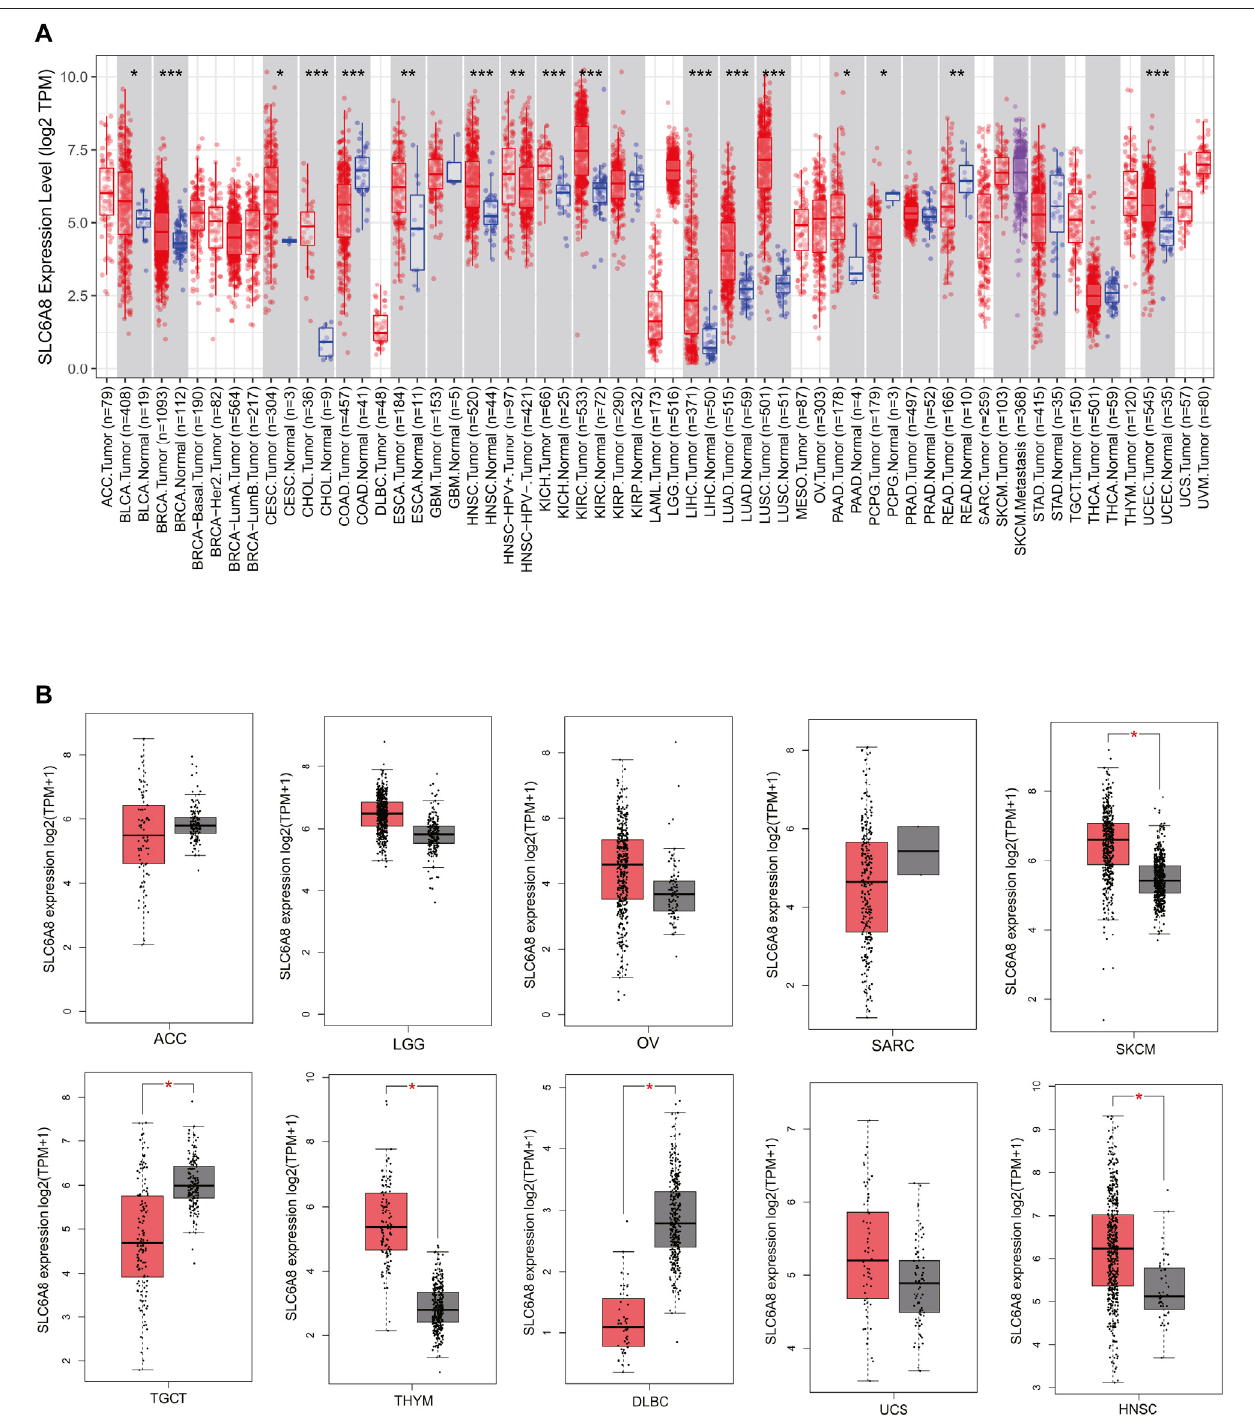
FIGURE 1 | SLC6A8 expressionpro fi lesincancers. (A) Pan-cancer differential-expressiondatafor SLC6A8 betweentumortissuesandpairednormaltissuesbased on TCGA data. (B) Analysis of SLC6A8 expression levels in tumor tissues versus corresponding normal tissues via GEPIA2 platform. * p < 0.05, ** p < 0.01, *** p < 0.001.